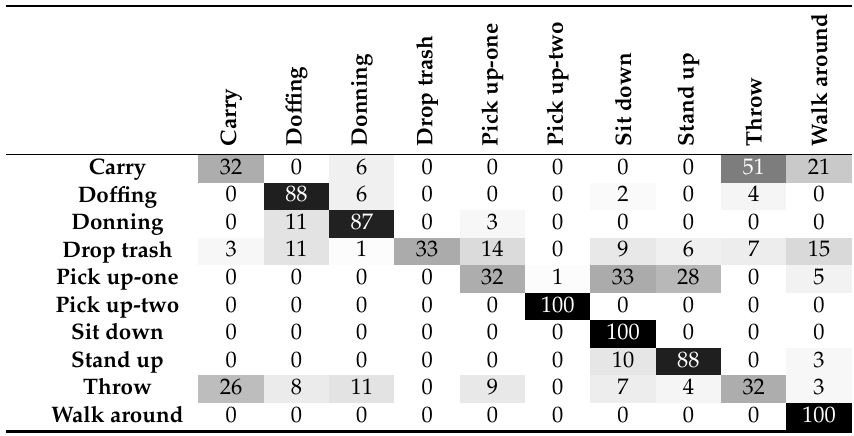
Table 6. Confusion matrix of central-oriented FWMDMMs based method, using cross-view validation scheme in terms of NUCLA